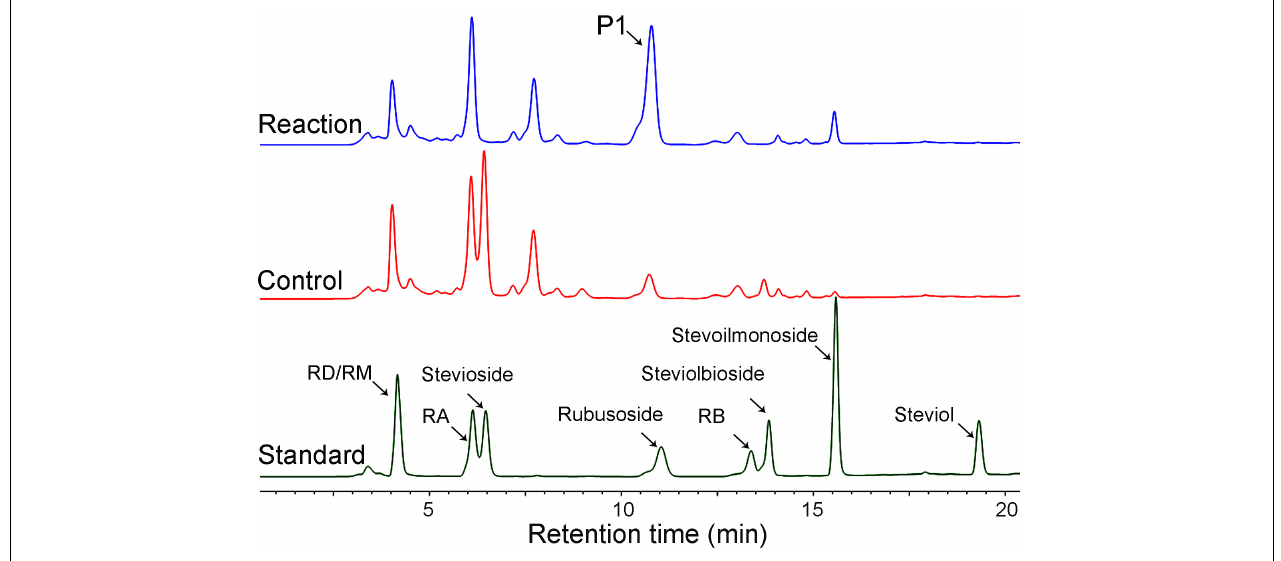
FIGURE 6 | HPLC analysis of the hydrolysis products of crude steviol glycosides extract (500 g/L) by Cs BGL. Reactions (blue line) were performed by incubating Cs BGL (15.5 U/ml) with crude steviol glycosides extract in 50 mM sodium phosphate buffer (pH 6.5) at 47.5 ◦ C for 2 h. P1 indicates rubusoside. The control (red line) was performed by inactive enzyme under the same condition, with the same reactions. The standard substrates are shown in dark green line.